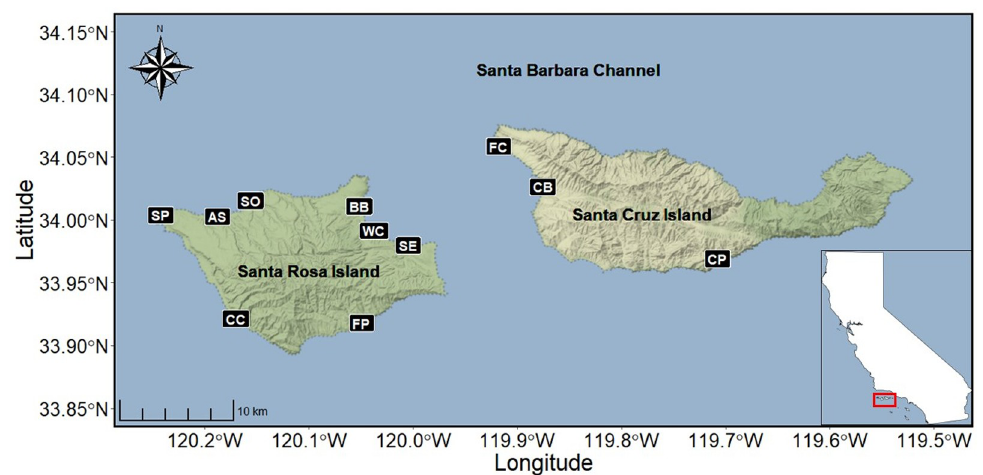
Fig 1. Locations of the study beaches on Santa Rosa and Santa Cruz Islands off the California, USA, coastline (inset). Abbreviations: SP—Sandy Point, SO—Soledad, AS—Arlington Springs, BB—Bechers Bay, WC—Water Canyon, SE— Southeast Anchorage, FP—Ford Point, CC—China Camp, FC—Forney’s Cove, CB—Christy Beach, CP—Coches Prietos. Attribution: Map tiles by Stamen Design, under CC BY 3.0. Data by OpenStreetMap, under OdbL.